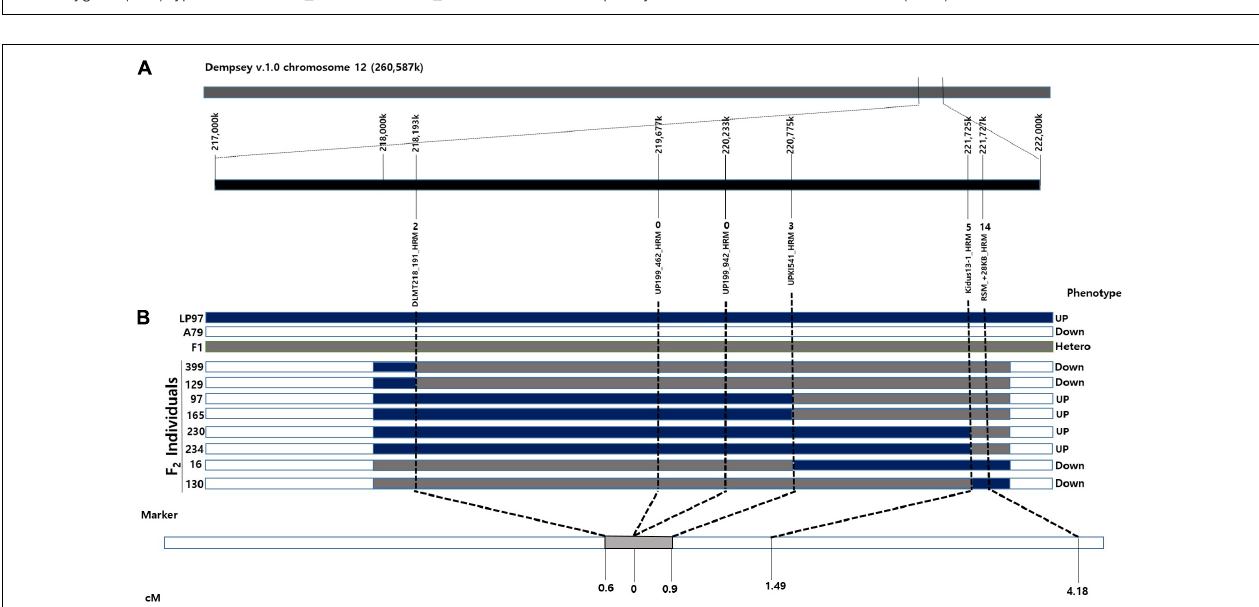
FIGURE 4 | Synteny between the genetic and physical maps at the CapUp region in the LA F 2 population. (A) The candidate CapUp region is located between 218 and 222 Mbp on chromosome 12. LP97 (blue) is homozygous recessive, F 1 (gray) is heterozygous, and A79 (white) is homozygous dominant. The names of the HRM markers are indicated above the horizontal black line. Recombinant plants are indicated above the HRM markers. (B) Genetic location of the CapUp locus in the LA F 2 population. The CapUp locus was mapped between DLMT218_191 and UPKI541, which are located at 0.6 and 0.9 cM, respectively.